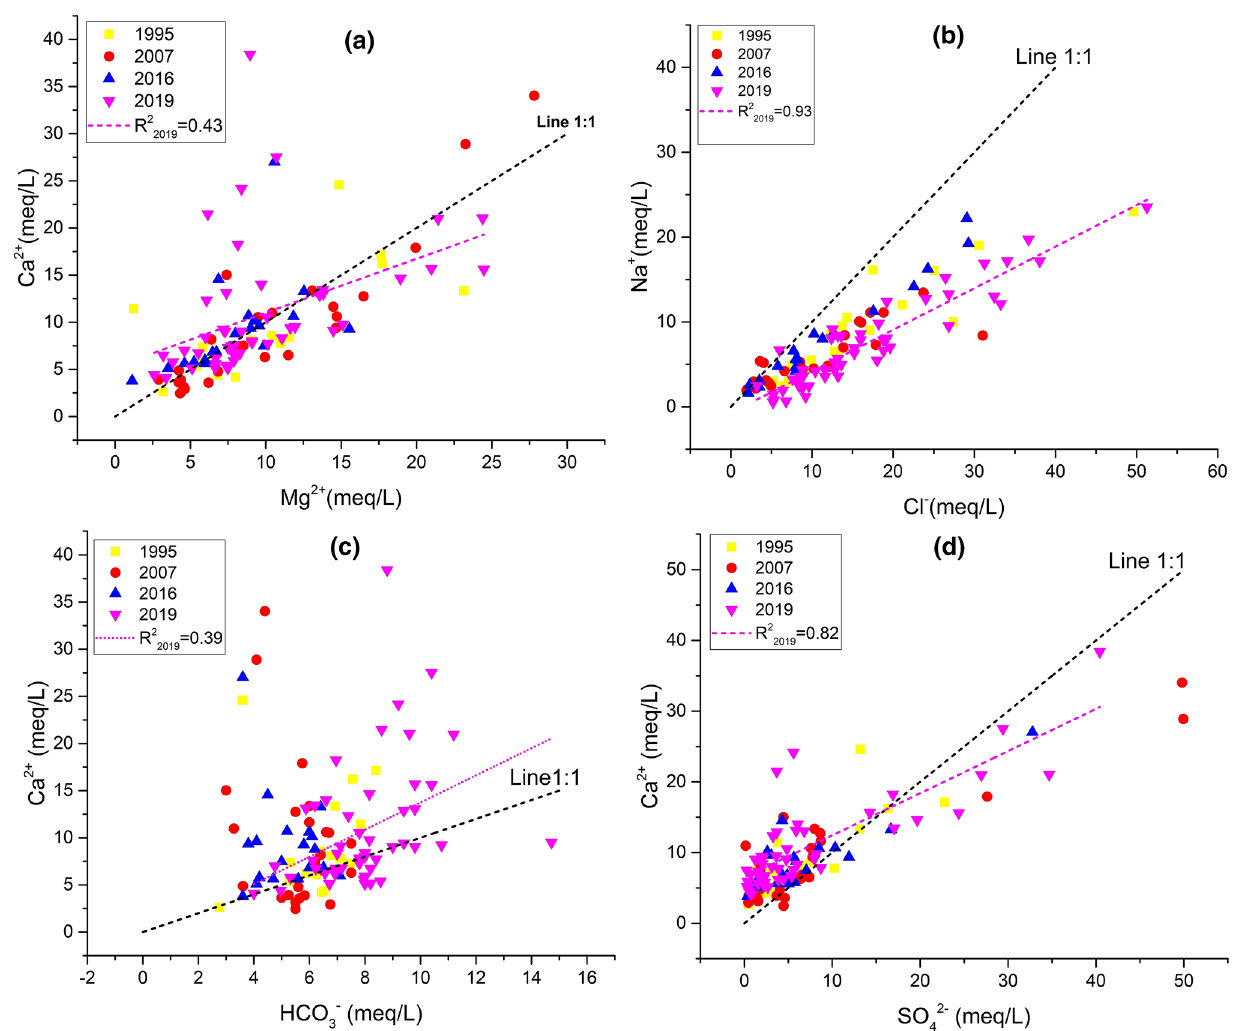
Fig. 6 Correlation diagram: a Ca 2+ vs Mg 2+ , b Na + vs Cl − , c Ca 2+ vs HCO 3− , d Ca 2+ vs SO